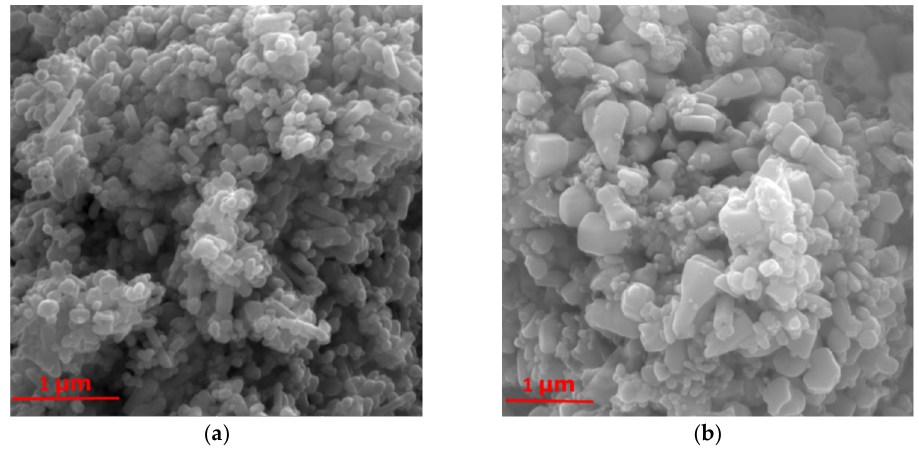
Figure 1 . Scanning Electron Microscopy images: ( a ) ZnO N ; ( b ) ZnO A . Figure 1. Scanning Electron Microscopy images: ( a ) ZnO